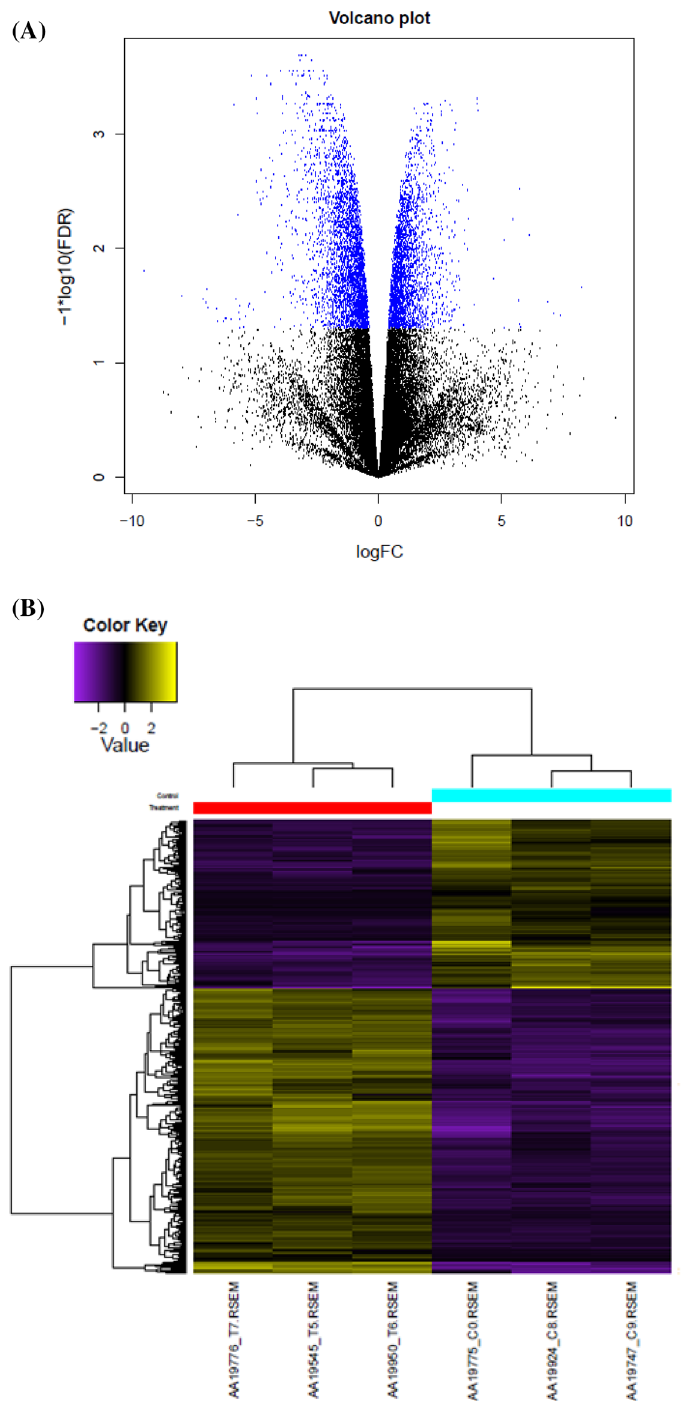
Figure 3. ( A ): A volcano plot illustrating the Log2-fold change between the treatments versus control plants. Blue dots represent significantly DEGs between treatment (24-h post 0.1 mM salicylic acid) and control (distilled water treatment) plants, ( B ) : Heat Map plot of differential expression genes between the treatment and